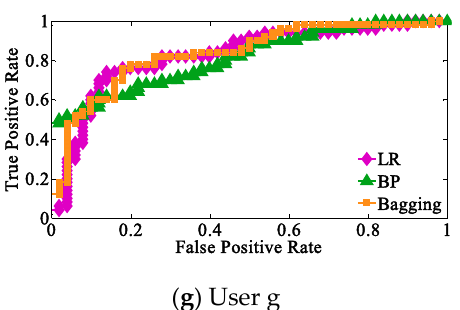
Figure 7. Comparisons of receiver operating characteristic (ROC) curves for the three classifiers from subjects ( a – g ).